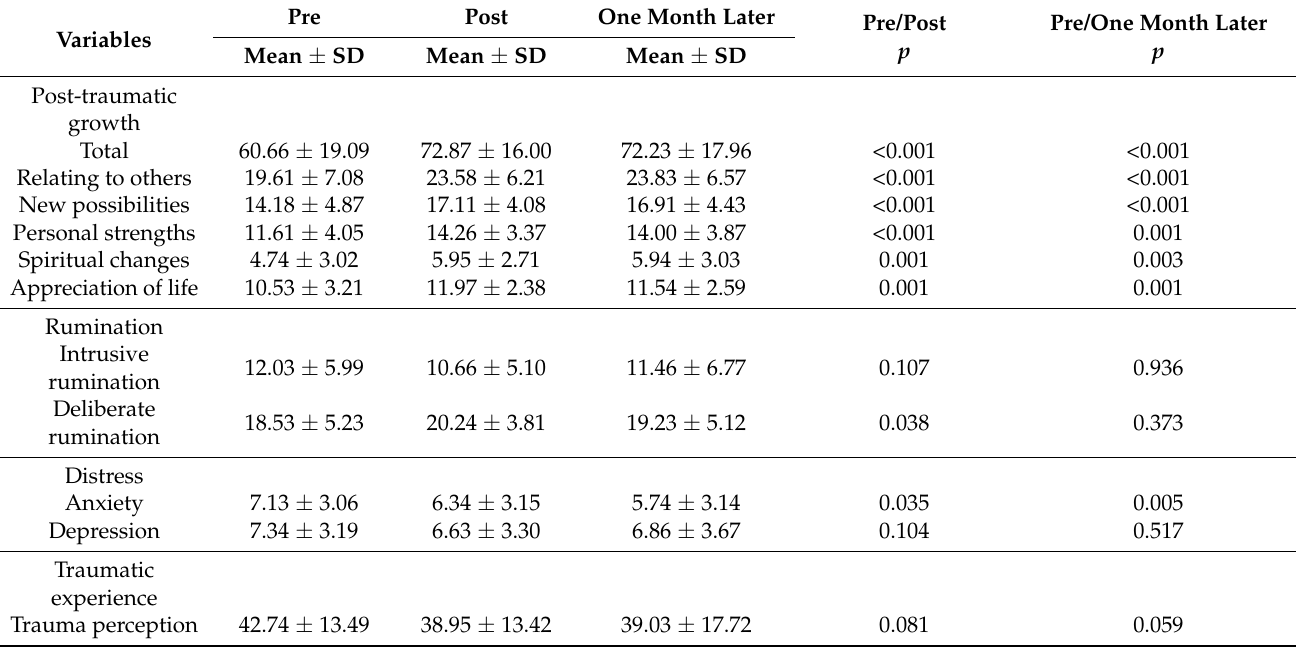
Table 2. Comparison of the effect of post-traumatic growth